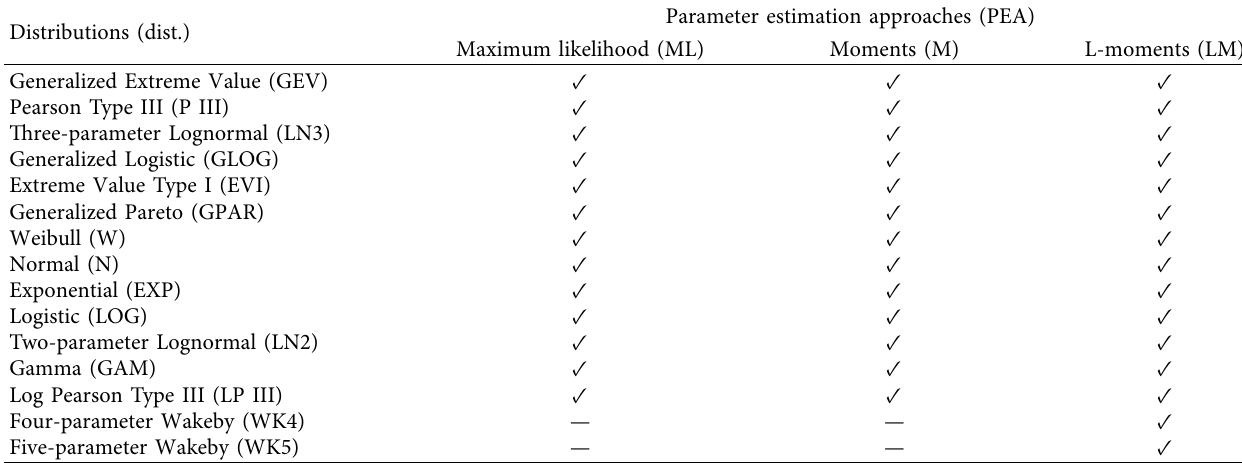
Table 3: Teoretical probability distribution models considered in the